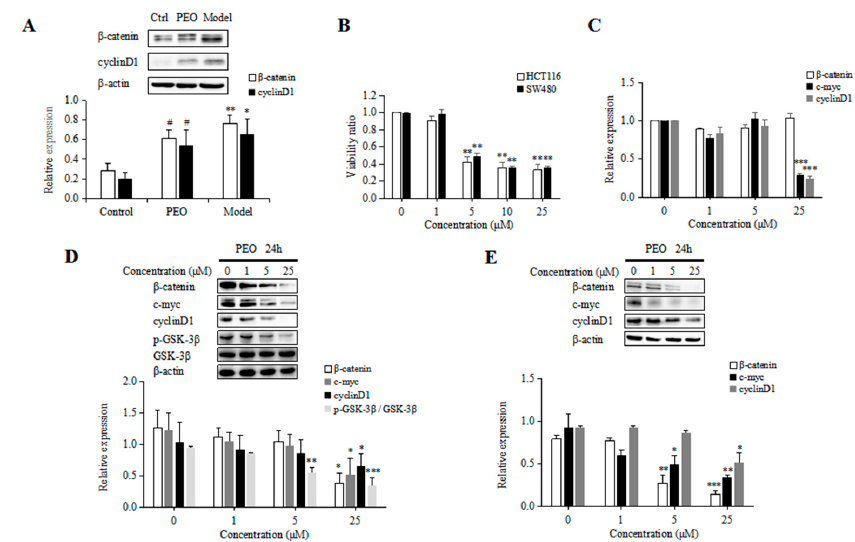
Figure 3. ( A ) PEO inhibits the expression of β -catenin and cyclinD1 in intestinal tissues of animals; ( B ) Anti-proliferative effects of different concentrations of PEO on the growth of HCT116 and SW480 cells; ( C ) PEO inhibits the mRNA expression of c-myc and cyclinD1 in HCT116 cells; ( D ) PEO inhibits the expression of β -catenin, c-myc, cyclinD1 and p-GSK-3 β in HCT116 cells; ( E ) PEO inhibits the expression of β -catenin, c-myc and cyclinD1 in SW480 cells. Density values were normalized to levels of β -actin. Data represent the means ± SE of independent experiments. # p < 0.05 relative to model group, * p < 0.05, ** p < 0.01,*** p < 0.001 relative to control group.